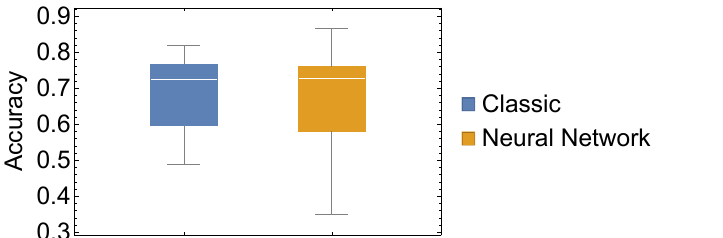
Figure 6. Experiment I: Box whisker chart of ACC values of our 15 datasets for both consid- ered